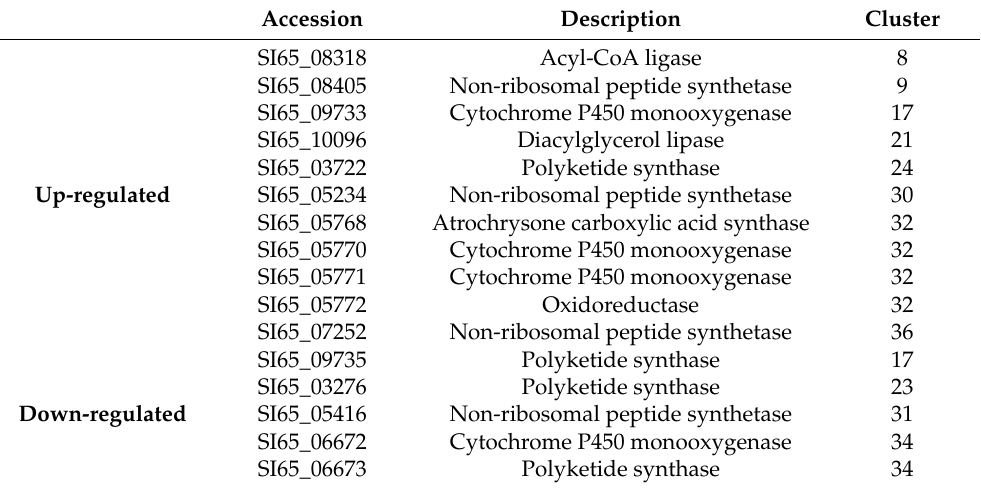
Table 1. Expression analysis and functional annotation of core genes in secondary metabolic gene clus-